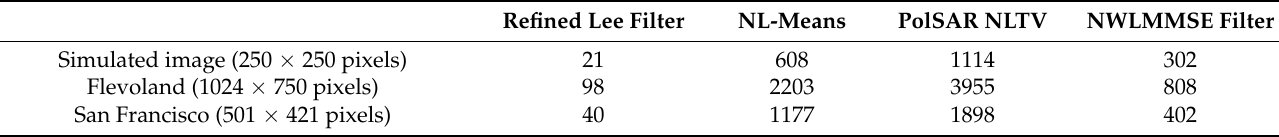
Table 2. Processing time (in seconds) of the different methods. Refined Lee